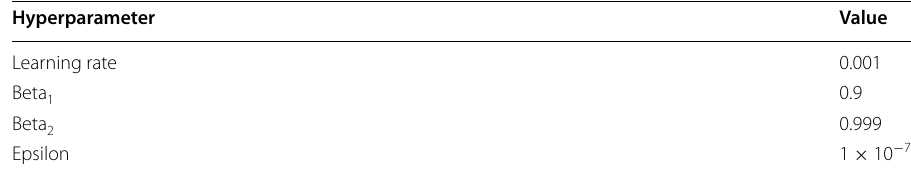
Table 8 Hyperparameters for the Adam optimizer